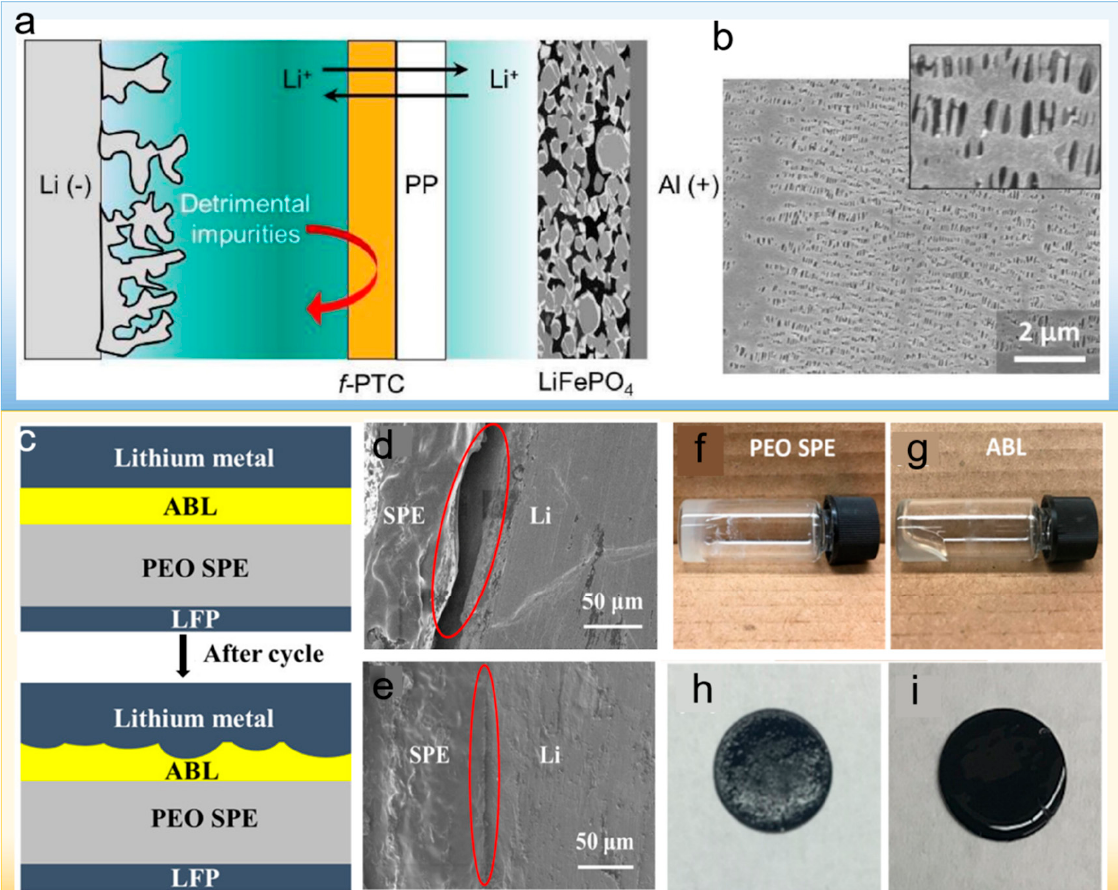
Figure 7. ( a ) A schematic for the suppressed crossover effect observed in the typical Li metal-based full cells by the addition of f -PTC. ( b ) SEM images (inset: magnified surface image) of and cycled PP laminated with f -PTC harvested from the Li||LiFePO 4 full cell [69]. Reproduced with permission. Copyright 2022, Elsevier ( c ) Schematic of the interface contact between Li metal anode and SPE before and after repeated cycles with ABL. ( d , e ) Cross-sectional SEM images of symmetric cells (Li/SPE/Li) after being charged to 20 mAh cm 2 at 0.04 mA cm 2 current density. ( d ) Without and ( e ) with ABL. The working temperature was set as 50 °C for all batteries. Reproduced with permission. The completely dried ( f ) PEO SPE. ( g ) ABL. The surface condition of the LFP cathode with PEO SPE ( h ) without and ( i ) with ABL [72]. Copyright 2019, American Chemical Society.